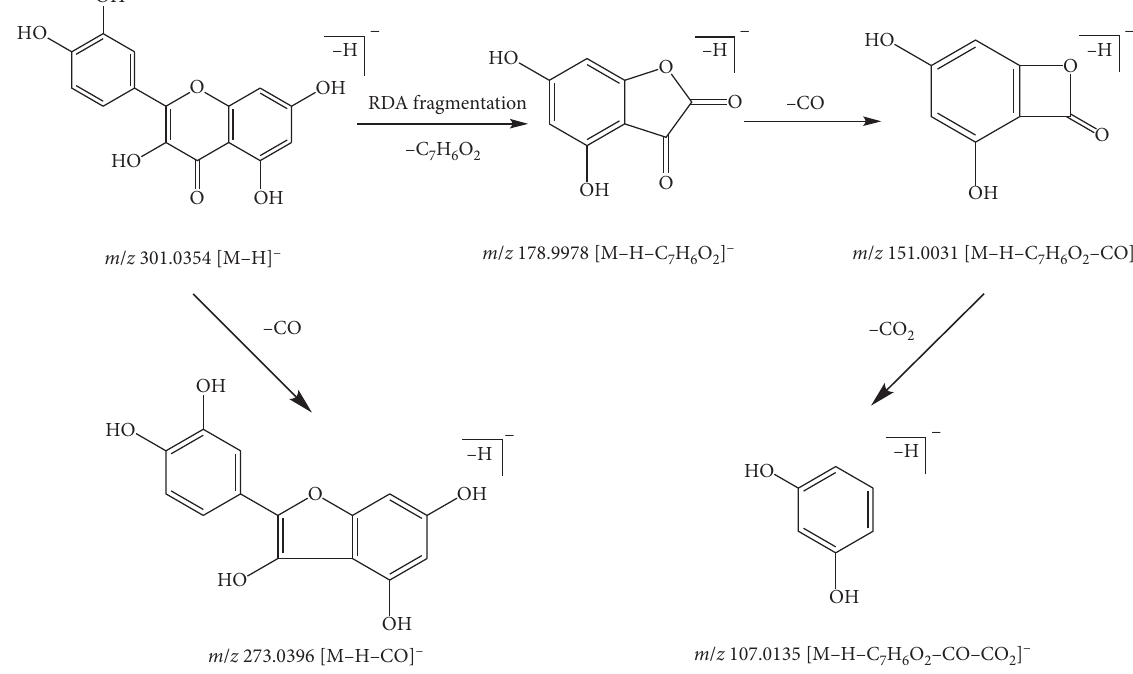
Figure 3: Possible fragmentation pathway of compound 11.